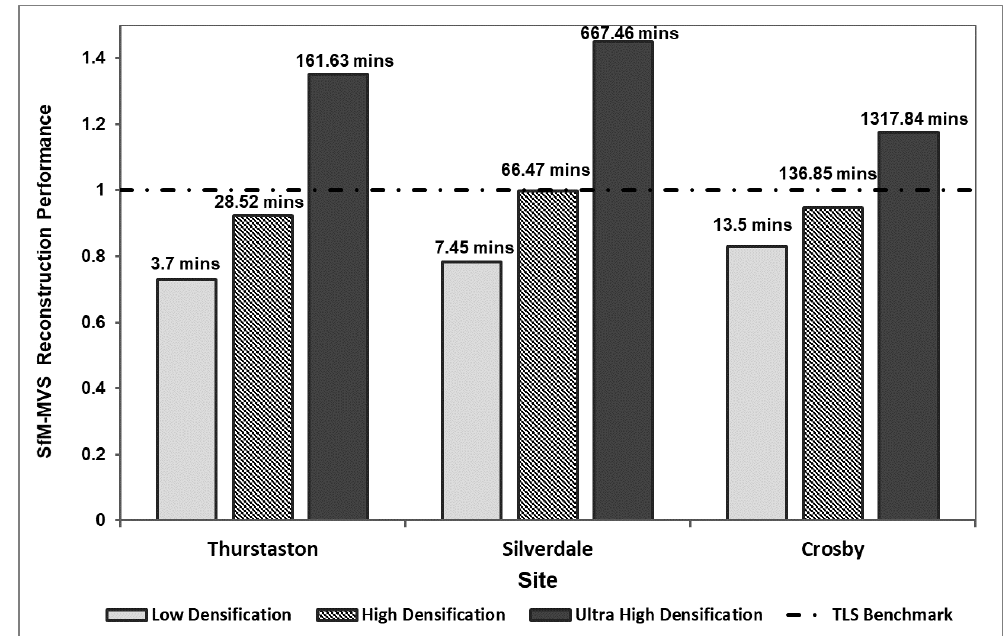
Figure 9. The overall SfM-MVS point cloud performance for each site and densification parameter compared to the TLS point cloud. The timescale for computer processing is included as a label on each column. ‘Ultra-high’ provided the best overall score but poorest processing times.